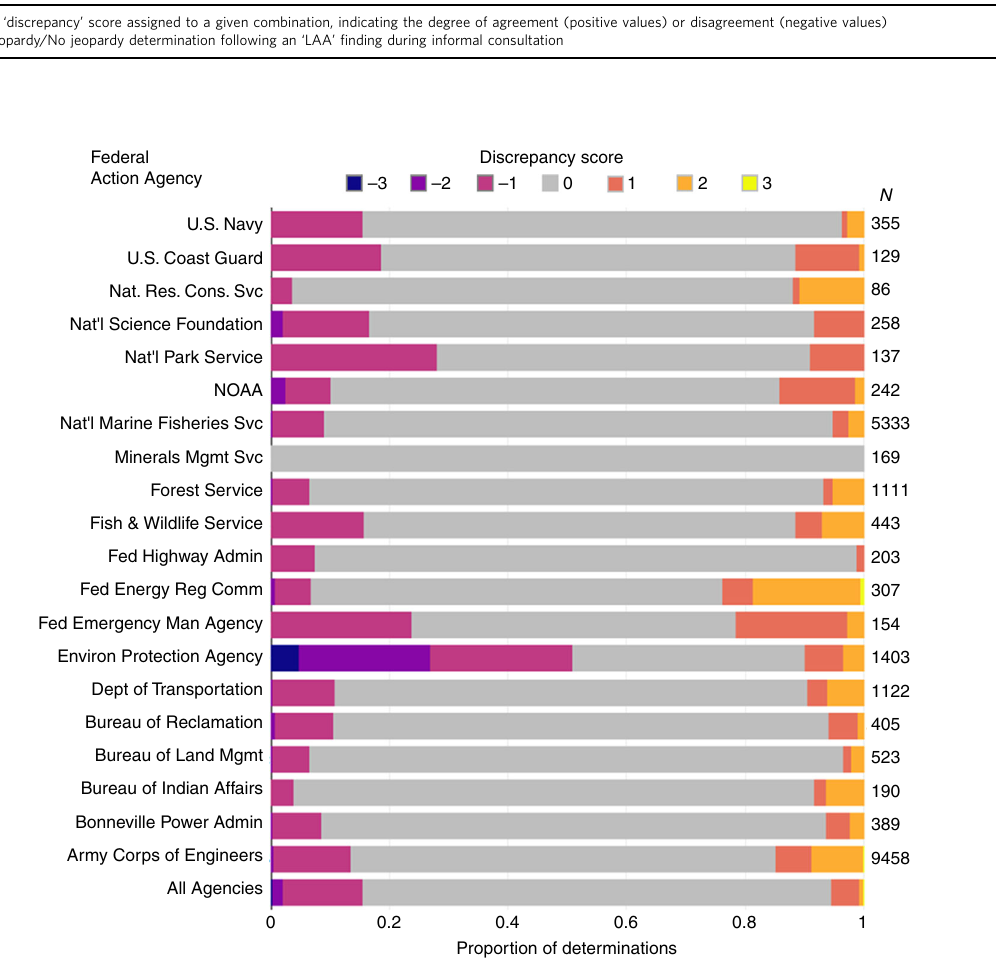
Fig. 2 Ordinal ‘ discrepancy ’ scores indicating the degree of disagreement on determinations between U.S. federal agencies and the National Marine Fisheries Service (NMFS) during section 7 consultations between 2000 and 2017. Positive values indicate an overestimation of effects by an agency, and negative values indicate underestimation. Bar length represents the percentage of determinations by an agency receiving each score, and ‘ N ’ provides the number of determinations. Federal agencies varied in rates of disagreement with NMFS during section 7 consultation under the U.S. Endangered Species Act. NMFS and the Fish and Wildlife Service may disagree with themselves because within each agency different divisions are responsible